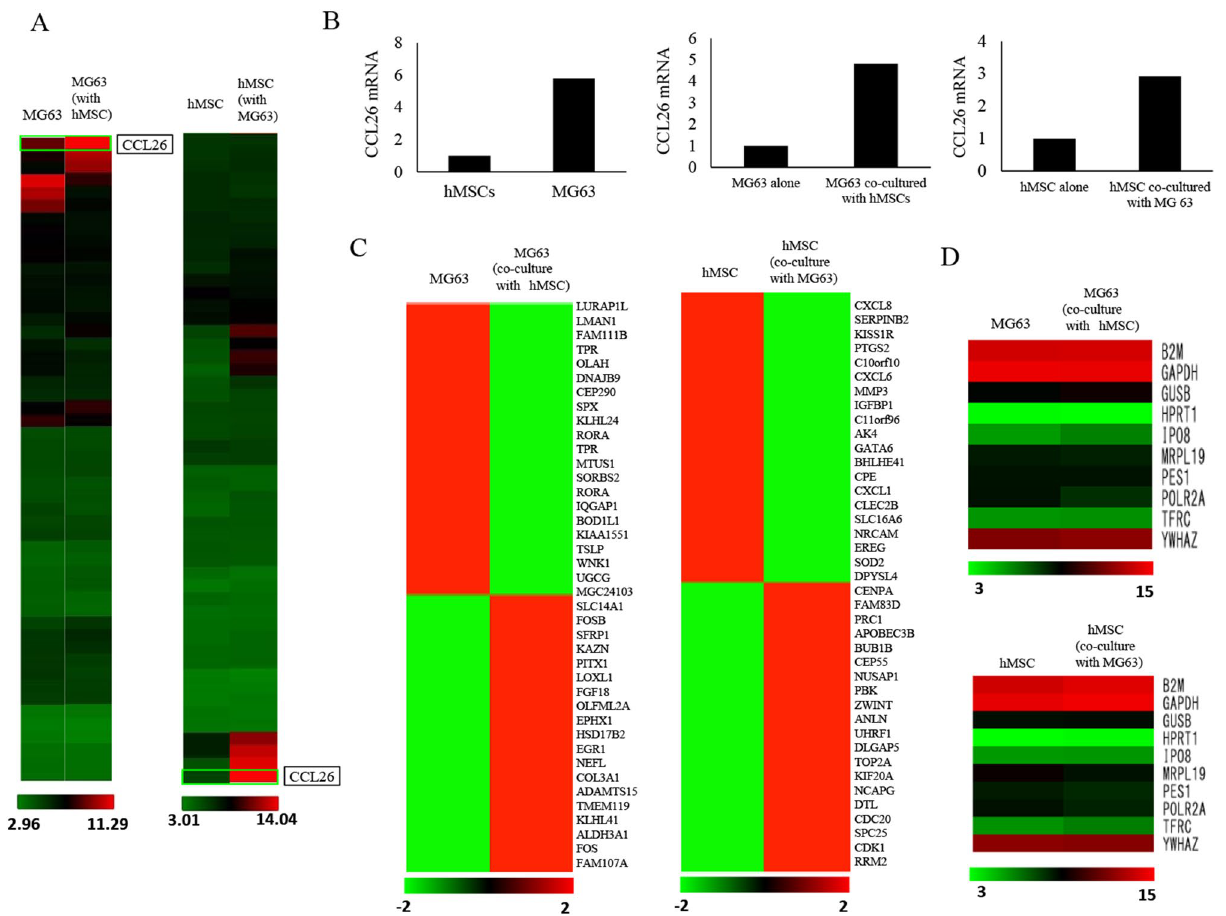
Figure 1. cDNA array profiling of genetic alterations and the expression of CCL26 in mono-cultured and co-cultured MG63 cells and hMSCs. ( A ) Changes in mRNA expression in hMSCs at 48 h after the co-culture with MG63 and in MG63 co-cultured with hMSCs. Co-culture condition increased the expression of CCL26 mRNA in both cell lines. ( B ) Relative expression of CCL26 mRNA in alone and co-cultured condition in each cell lines. Changes in the mRNA expression with high expression variability ( C ) and changes in the expression of housekeeping genes (control) ( D